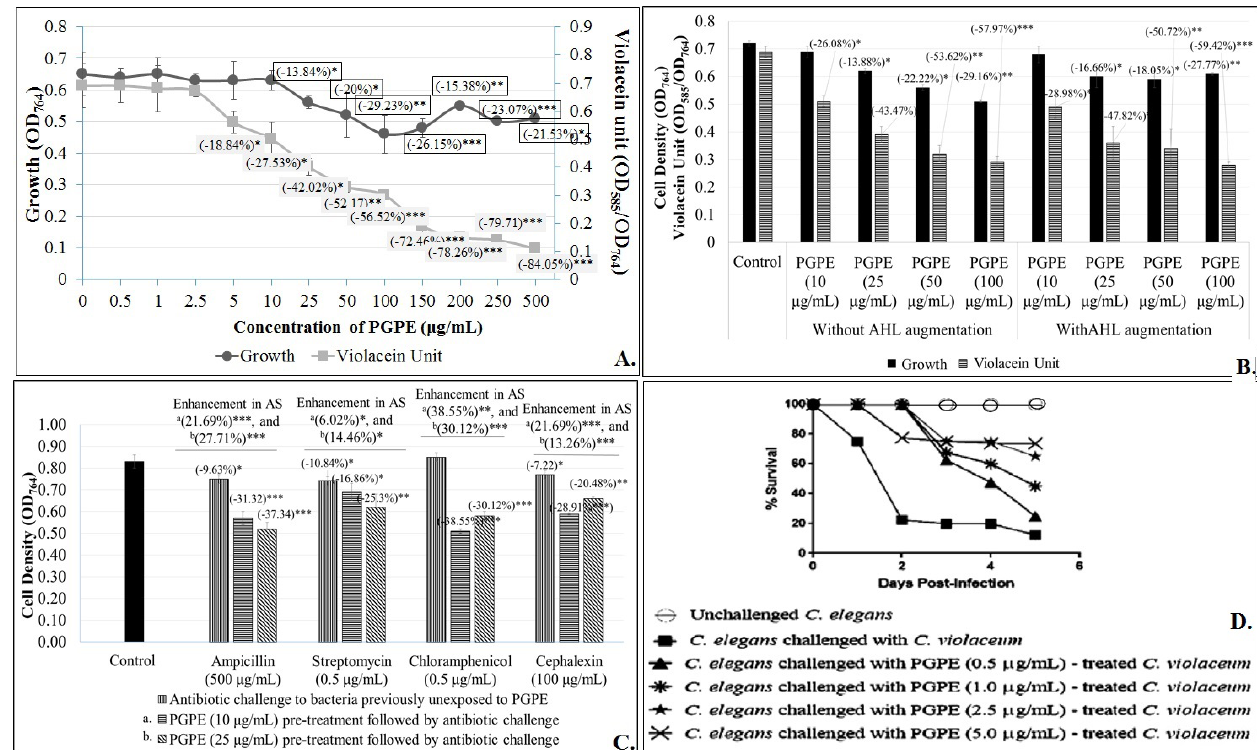
Figure 1. Effect of PGPE on C. violaceum . ‘Control’ in this figure is the vehicle control (0.5%v/v DMSO), which did not exert any effect on growth and violacein production of C. violaceum . ( A ) Effect of PGPE on growth and QS- regulated violacein production in C. violaceum: Bacterial growth was measured as OD ; OD of violacein was measured at 585 nm, and Violacein Unit was calculated as the ratio OD /OD 764 585 764 (an indication of violacein production per unit of growth); Catechin (50 µg/ml) did not exert any effect on growth of C. violaceum , but inhibited violacein production by 47.69±0.03%. ( B ) PGPE acts as a signal-response inhibitor against C. violaceum . ( C ) PGPE-pre-treatment enhances susceptibility of C. violaceum to different antibiotics. ( D ) PGPE-treatment attenuates virulence of C. violaceum towards C. elegans: Catechin (50 µg/ml) and ampicillin (500 µg/ml) employed as positive controls conferred 100% protection on worm population, and pre-treatment of bacteria with PGPE at concentrations (10, 25, 50 and 100 µg/ml) other than those shown in figure allowed 75%, 77.5%, 80%, and 75% worm survival, respectively; DMSO present in the ‘vehicle control’ at 0.5%v/v did not affect virulence of the bacterium towards C. elegans; DMSO (0.5%v/v) and PGPE at tested concentrations showed no toxicity towards the worm. * p <0.05, ** p <0.01, *** p <0.001; AS,